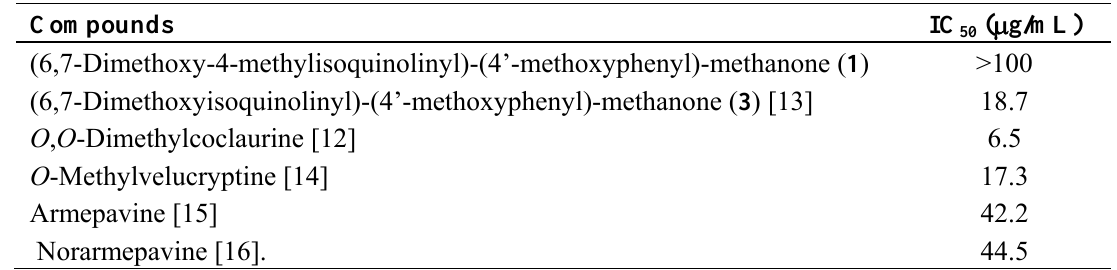
Table 2. In vitro cytotoxic activity against P388 cell